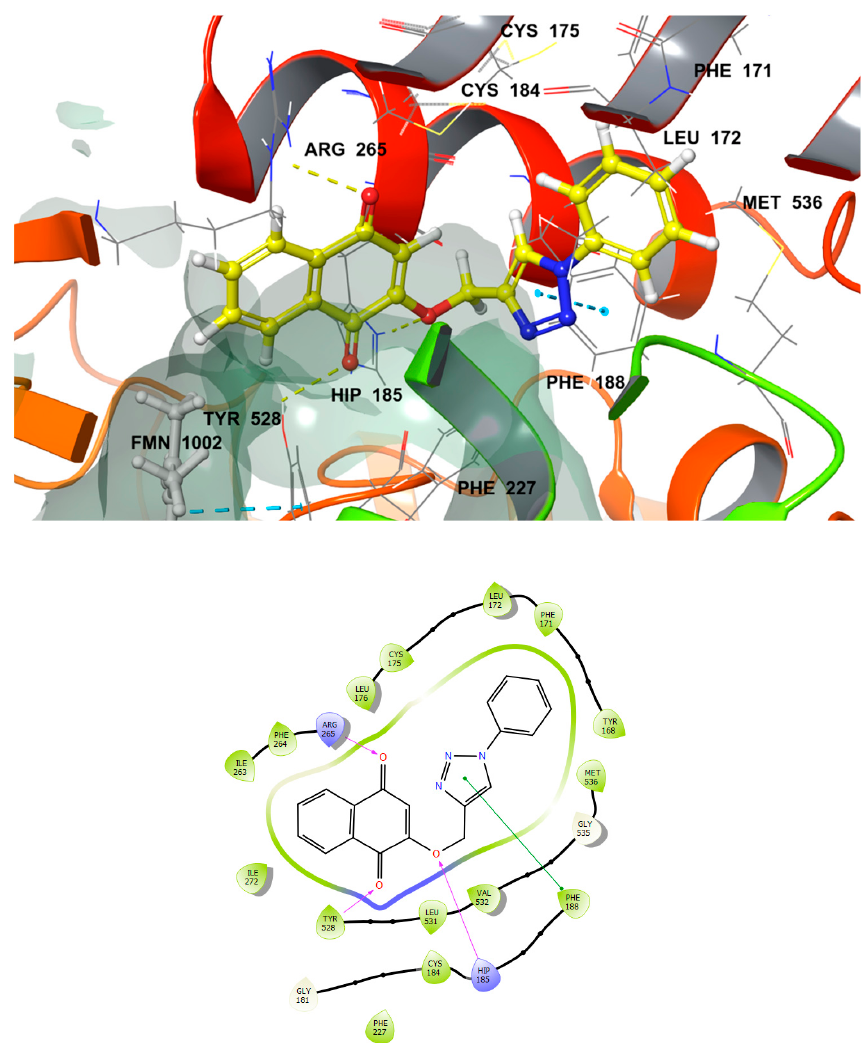
Figure 3. Binding mode prediction of 3j with Plasmodium falciparum enzyme dihydroorotate dehydrogenase (PfDHODH) (Protein Data Bank (PDB) code 1TV5).